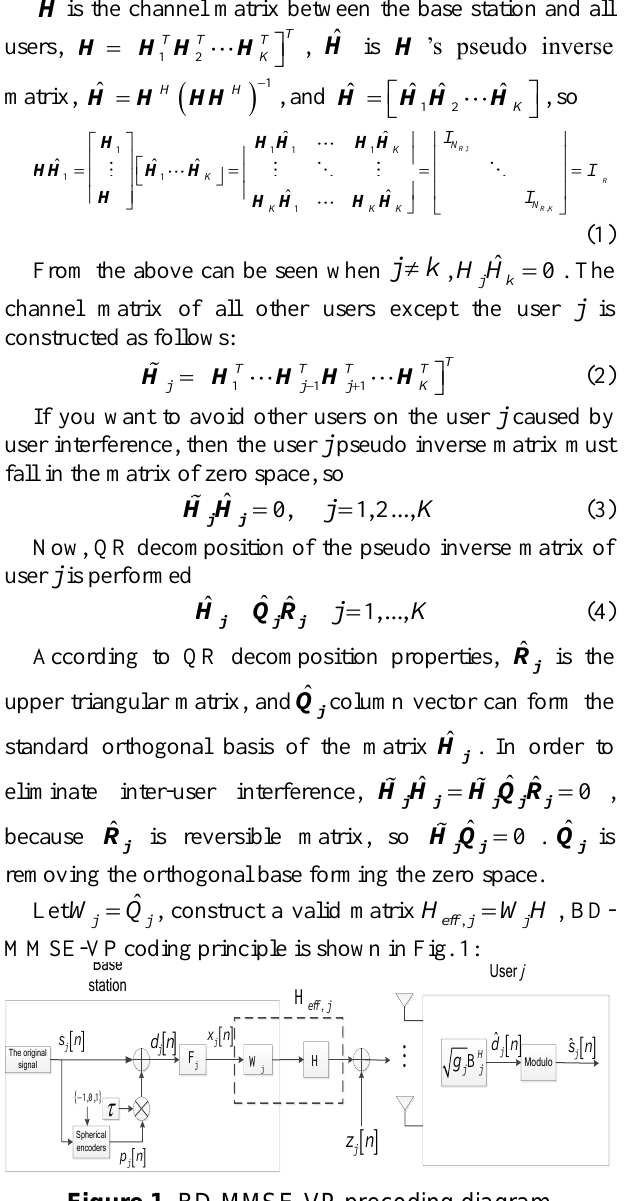
d n is the user j